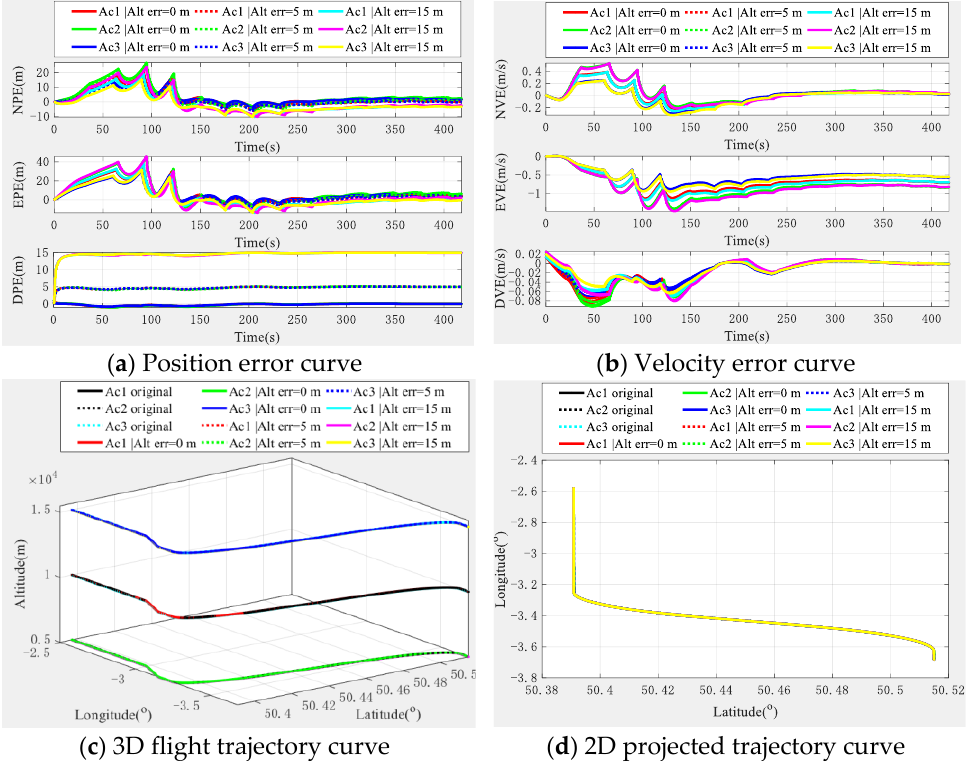
Figure 11. Navigation and positioning error curve when the formation is vertically collinear.